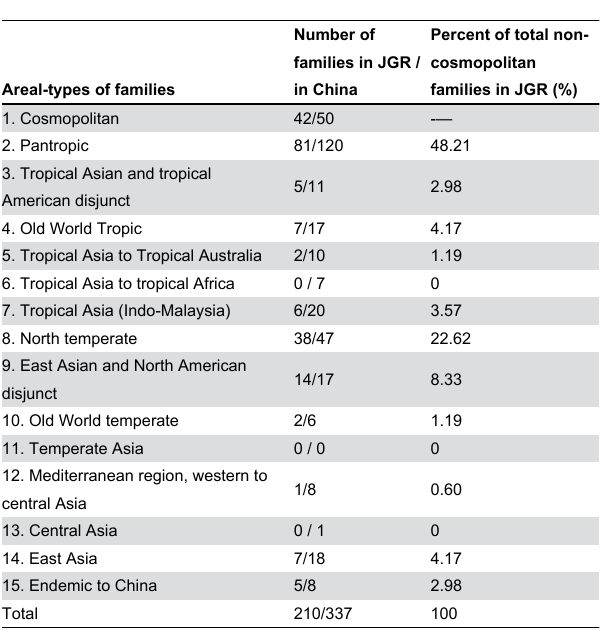
Table 8. Areal-types of families from the seed plant flora of Mount Jinggangshan region